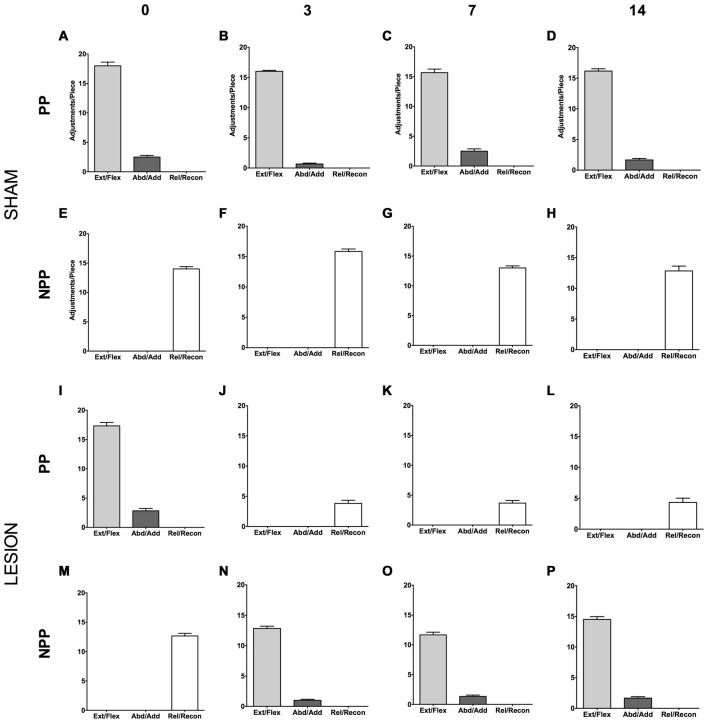
Effect of dCST lesion on the pasta test. The histograms depict the average number of motor adjustments performed with the PP and NPP, both in the Sham (A–H) and the Lesion Group (I–P). Error bars represent mean ± SEM.